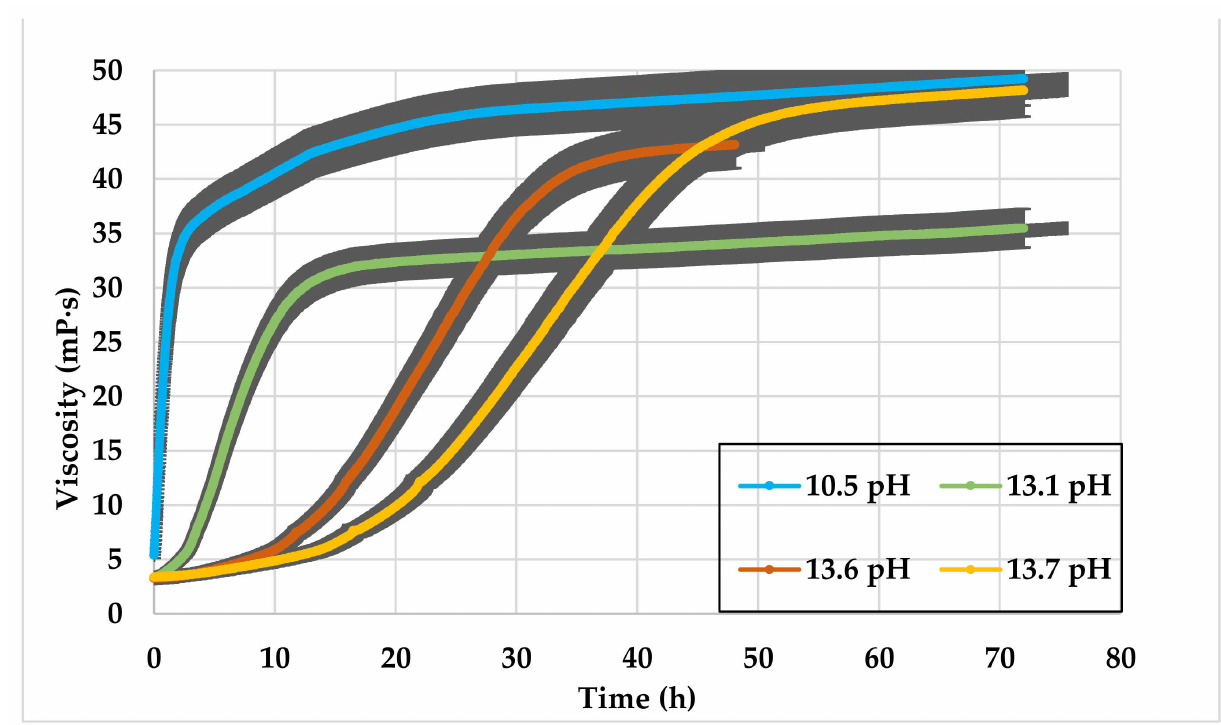
Figure 8. SW based viscosity versus time, 0.5 wt% CMHPG polymer mixed with 10 vol% high pH GLDA > 10.